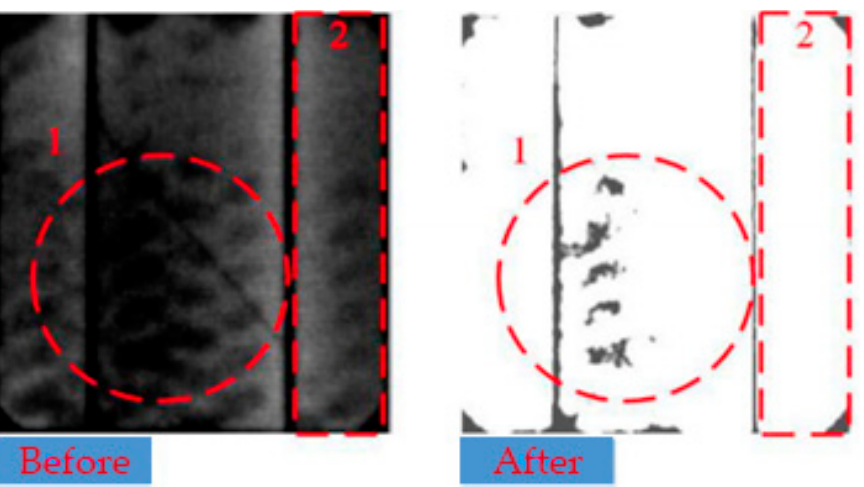
Figure 4. Before and after using the proposed EL detection method proposed by. Points 1 and 2 show how shadows that might seem are cracks are eliminated [35].